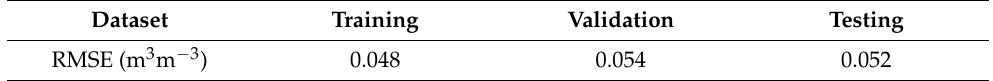
Table 5. RMSE values on training, validation, and testing datasets.